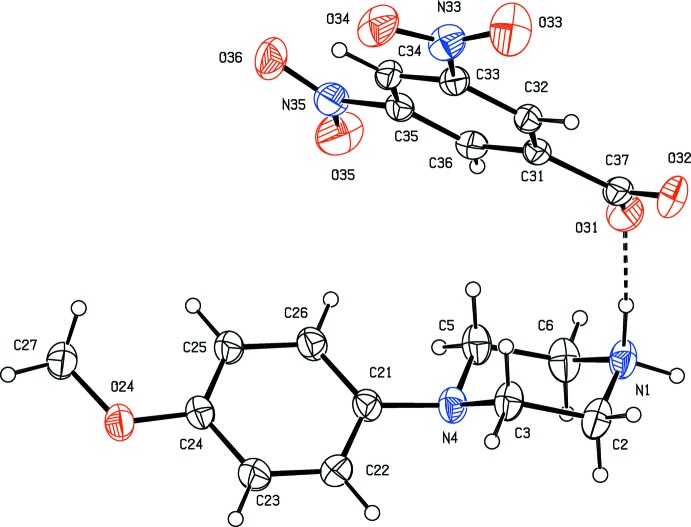
The independent components of compound (II) showing the atom-labelling scheme and the hydrogen bond, drawn as a dashed line, within the selected asymmetric unit. Displacement ellipsoids are drawn at the 30% probability level.